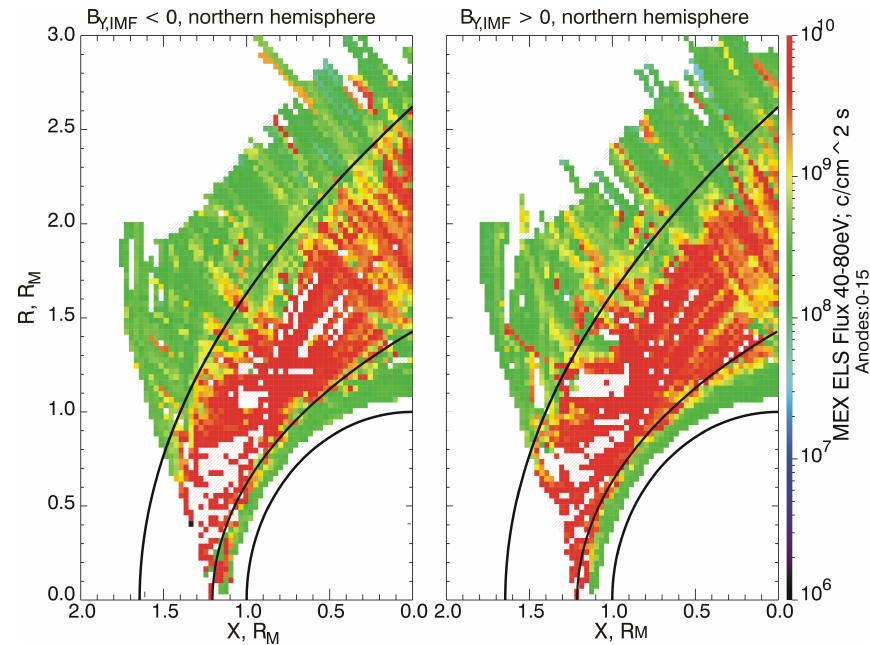
Fig. 2. Maps of electron fluxes in the Northern dayside Hemisphere for B y IMF < 0, and B y IMF > 0.